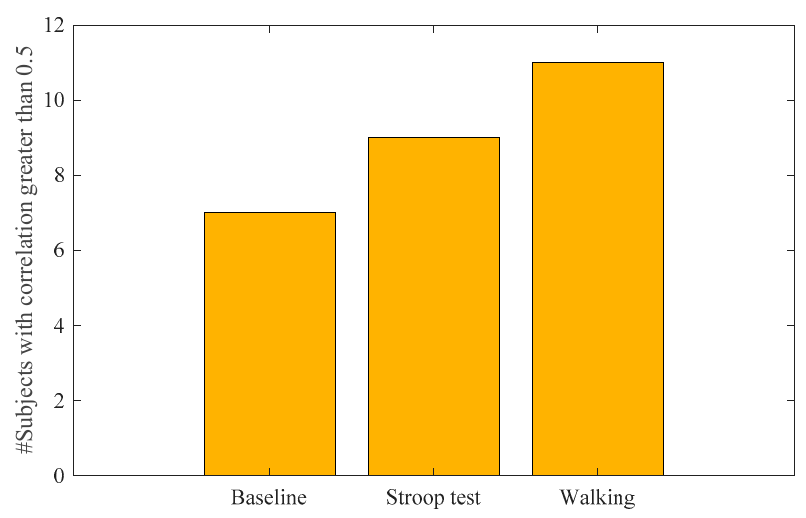
Figure 6. Effect of hydration time on forehead EDA.